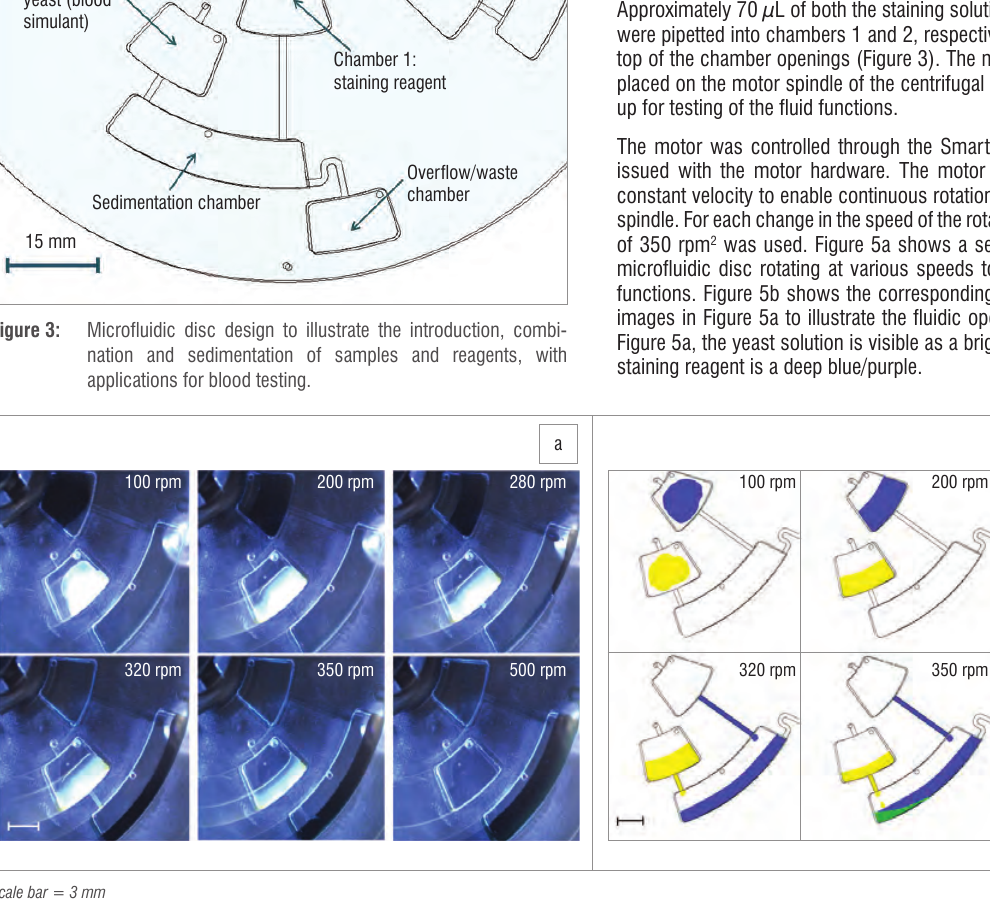
The microfluidic disc at various spin speeds to illustrate timed valving and combining of fluids: (a) images of the disc device captured using the experimental set-up and (b) corresponding sketches to illustrate the fluid interactions for each of the images in